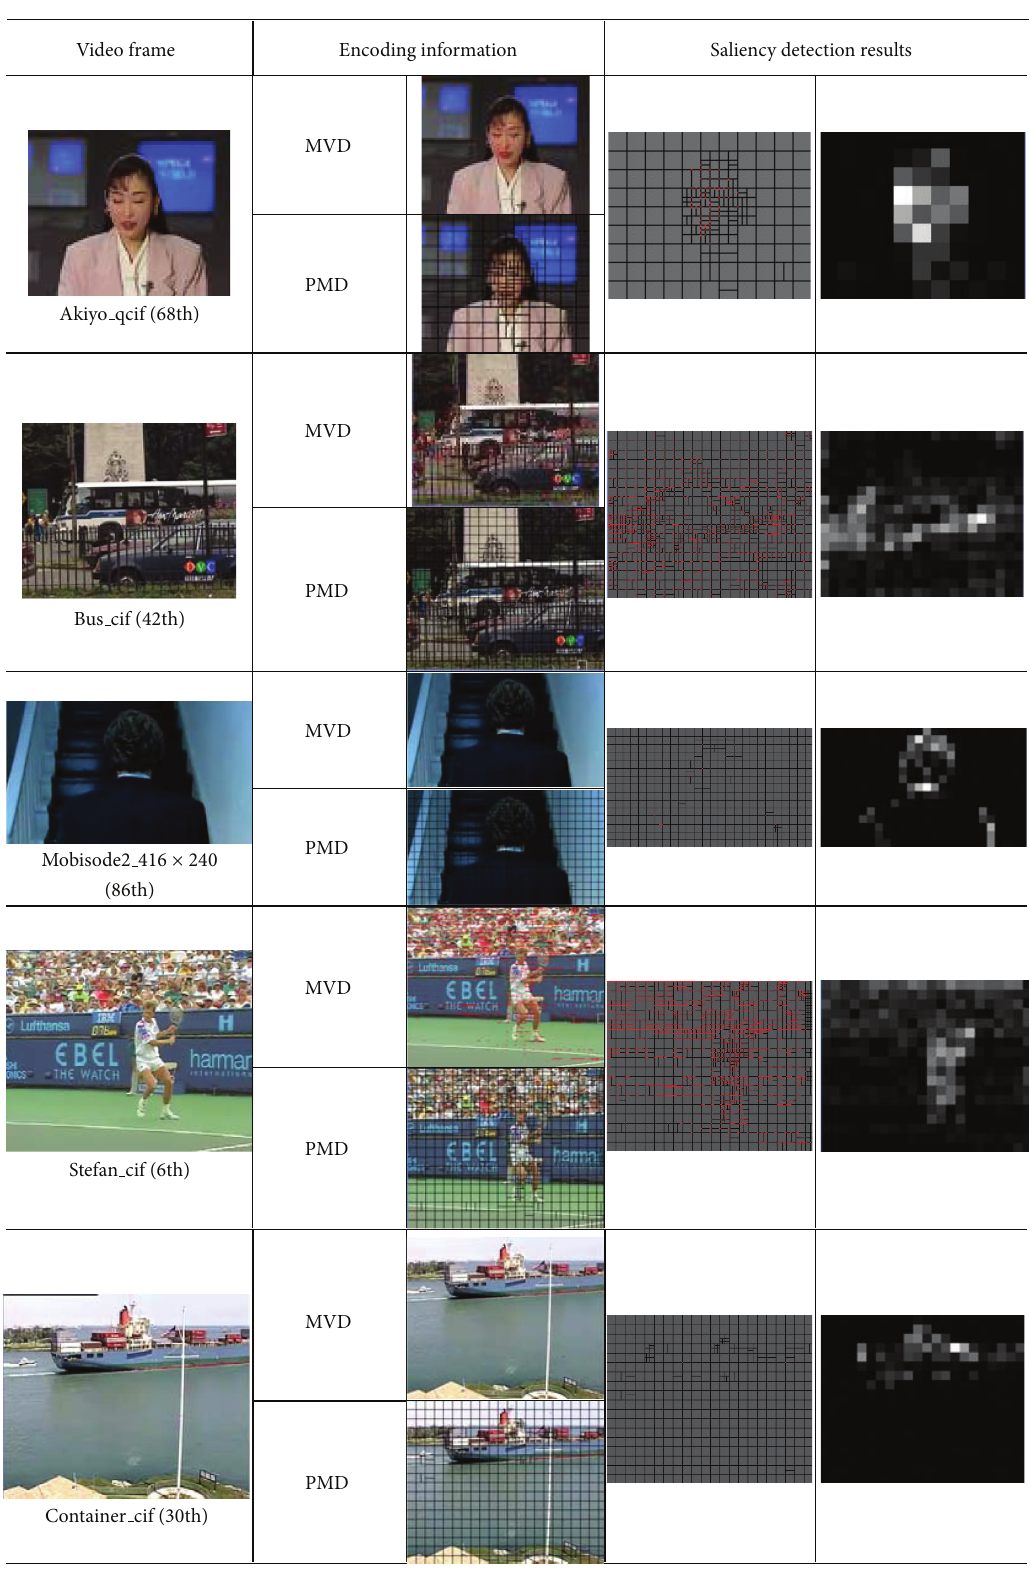
Figure 15: The saliency detection results of the proposed